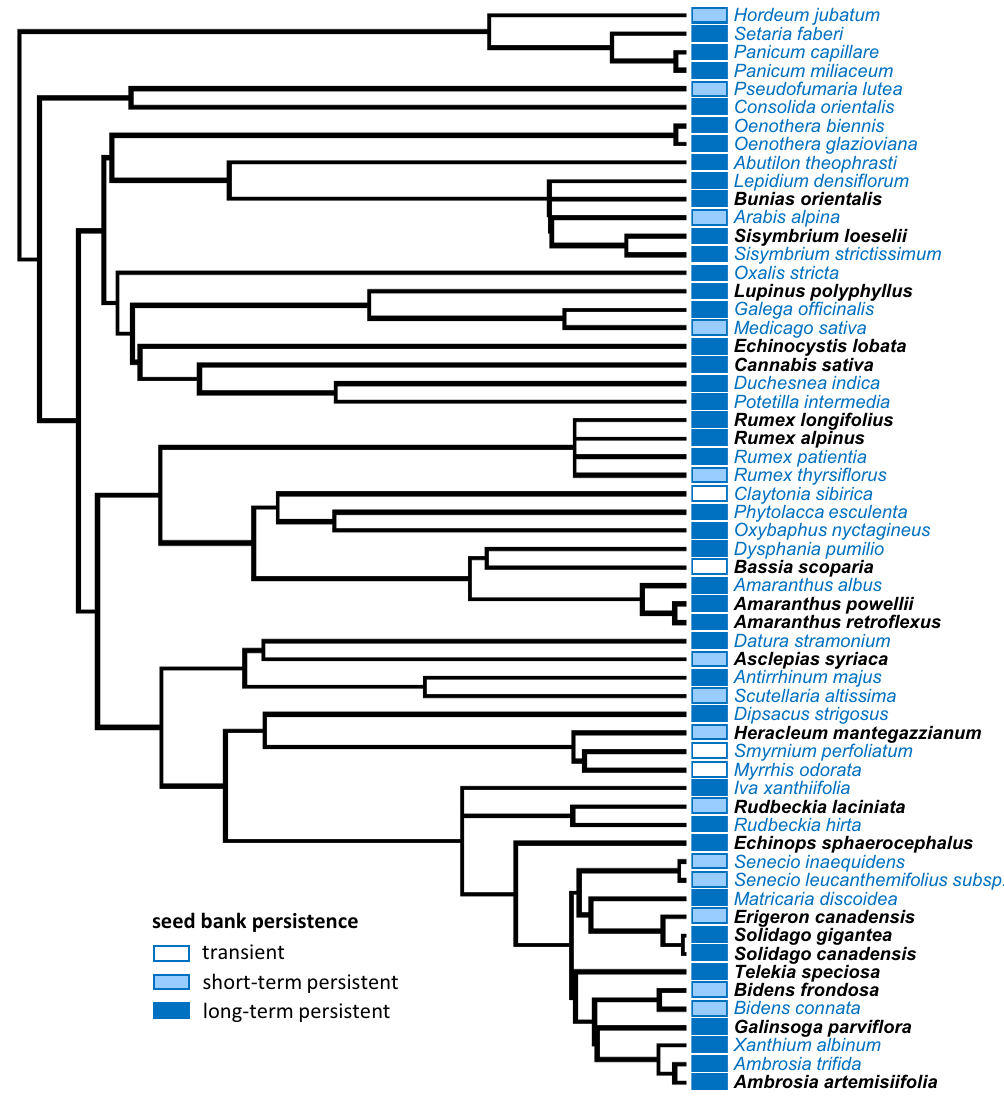
Figure 2. Plant phylogenetic tree and seed bank persistence derived from a 7.5-year seed burial experiment. Species in bold are classified as invasive in the Czech Republic, while those in blue are considered naturalized, according to the classification by Pyšek and colleagues (2012) 45